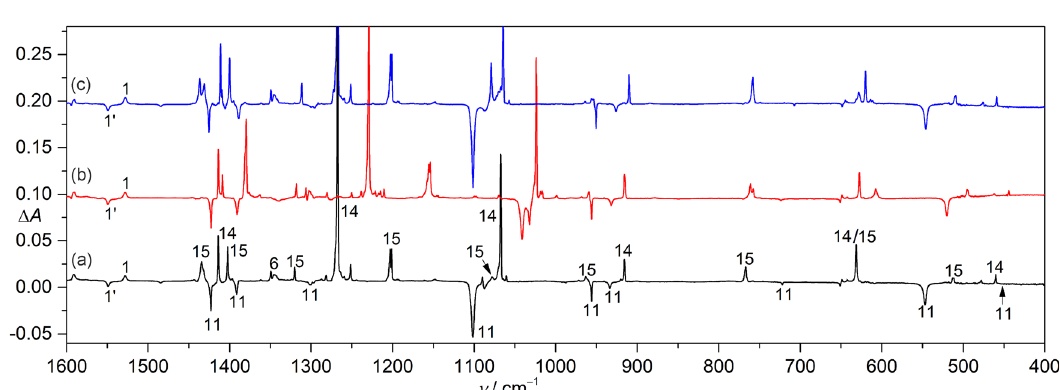
Fig. 4 IR difference spectra for the isotope-labeling experiments. a Expaned IR difference spectra (1600 – 400cm − 1 ) for the photo-induced (830 nm) conversion of CH 3 SOO (cid:129) ( 11 ) to CH 3 SO 2 (cid:129) ( 14 ) and CH 3 S(O) 2 OO (cid:129) ( 15 ). The spectra for the experiments with the 18 O- and 13 C-labeling samples are shown in b and c ,